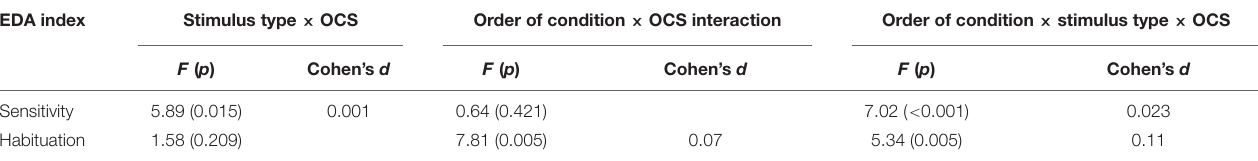
TABLE 5 | Mixed models: condition, presentation, and obsessive–compulsive symptoms (OCS) effects and